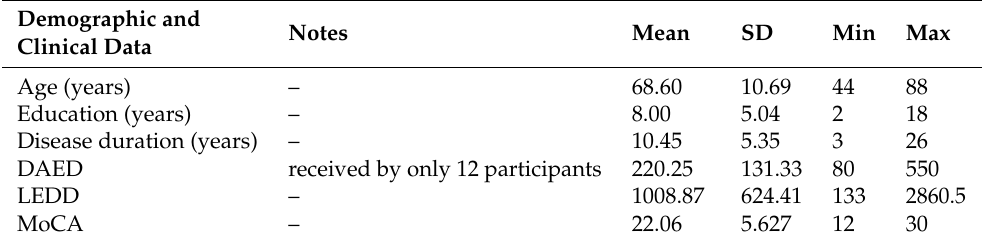
Table 1. Main demographic data: age, education, disease duration, Dopamine Agonists Equivalent Daily Dose (DAED; dopamine agonists were administered to only 12 participants out of 20), and Levodopa Equivalent Daily Dose (LEDD) according to [26]. The raw score of the Montreal Cognitive Assessment was then corrected according to the Italian normative data for cognitive impairment staging